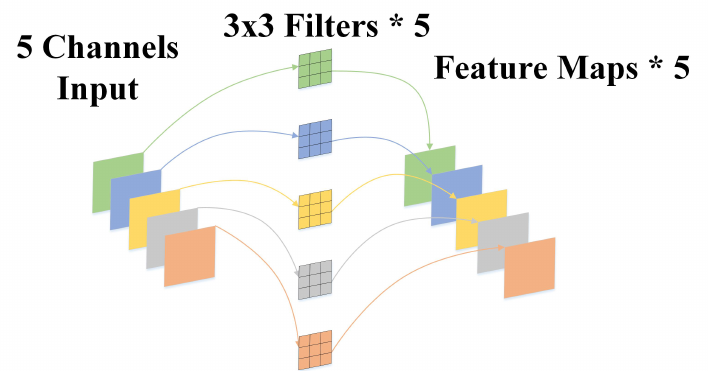
Figure 2. The process of DW convolution. Take the number of input data channels 5 and the kernel size 3 × 3 as an example. Each channel is convoluted by a